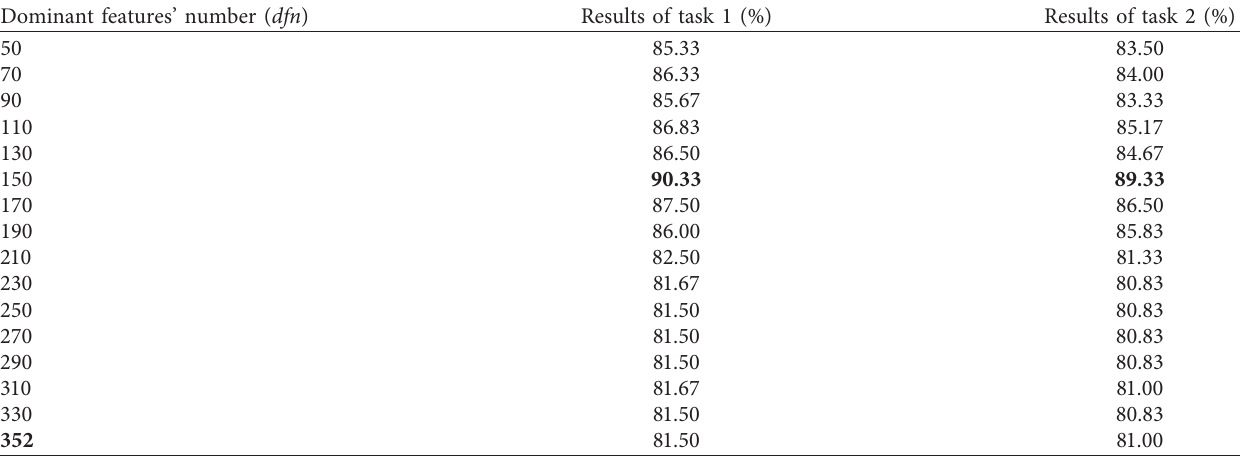
Table 9: Cross-domain fault diagnosis results of TFDD framework.